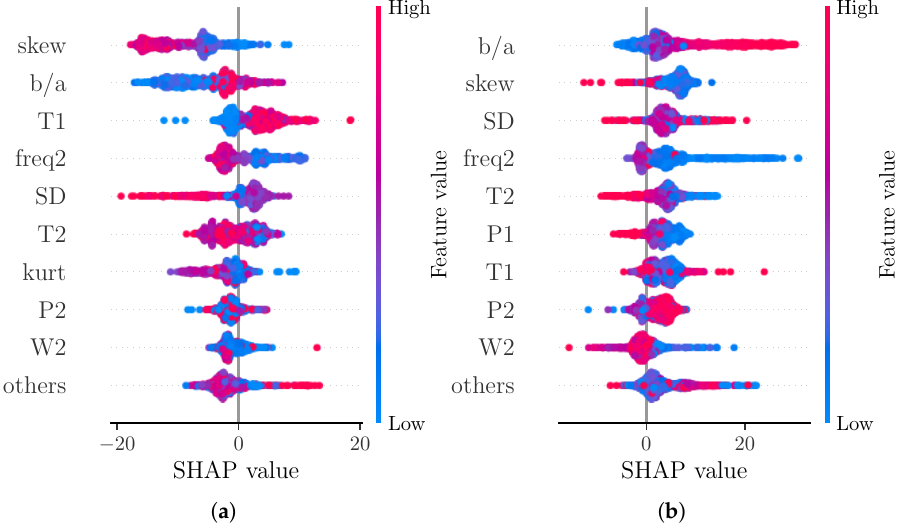
Figure 5. Beeswarm plot of SHAP values for subsets of samples of test set according to the MAE values of the prediction models. ( a ) error greater than two times the MAE, ( b ) error lower than half the MAE.